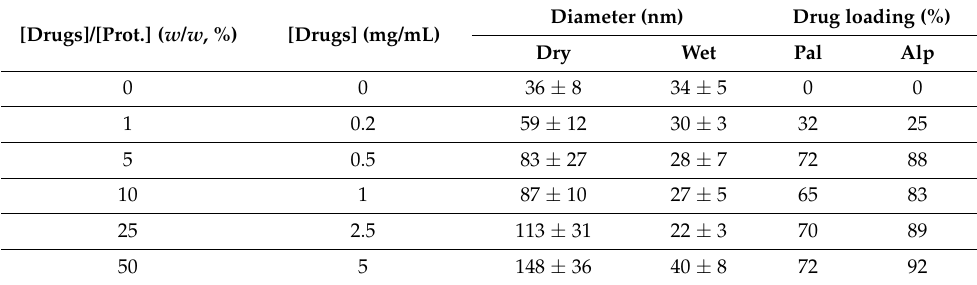
Figure 3. Determination of encapsulated drug concentrations in P(RGD)/Pal,Alp NCs. ( A ) Chromatogram of 2.5 mg/mL standard solution (1.25 mg/mL of each drug); drugs were mixed together to resemble the target sample matrix. The retention time (RT) was 11.5 and 12.6 min for Pal and Alp, respectively. ( B ) Chromatogram of a representative sample of encapsulated drugs analyzed after sonication. RTs were 11.6 and 12.6 min for Pal and Alp, respectively. ( C , D ) Standard calibration curves of Pal and Alp ( n = 3). Table 2. Diameter and drug loading of P(RGD)/Pal,Alp NCs a